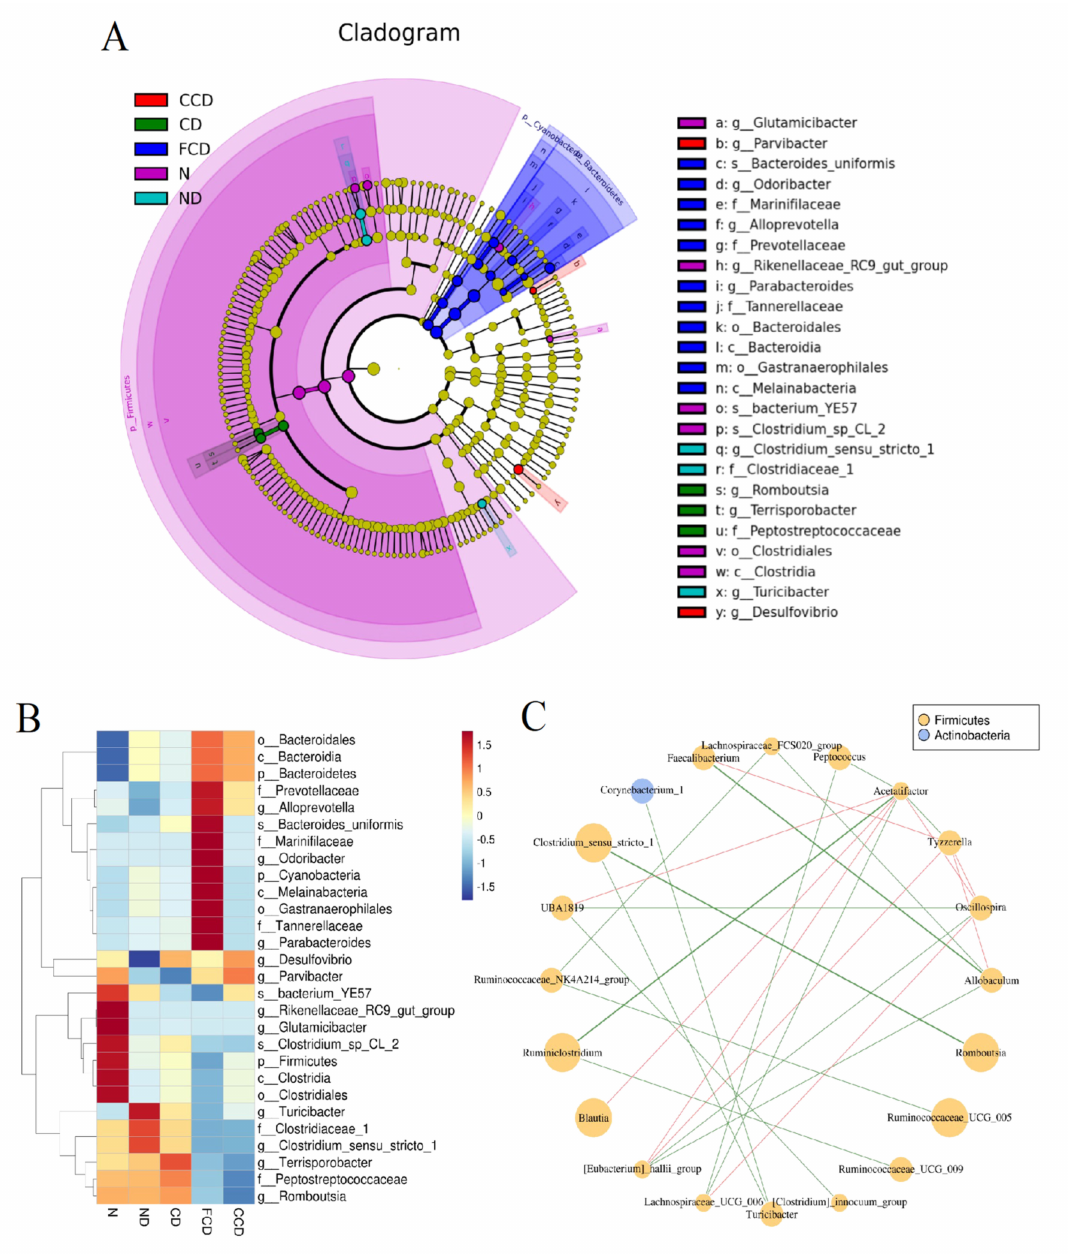
Figure 3. Linear discriminant analysis effect size analysis of microbiota compositions and network analysis of taxa. ( A ) Cladogram of microbiota compositions excluding the PCD group; ( B ) Heatmap of microbiota relative abundance; ( C ) Spearman’s correlation analysis of microbiota taxa, r cutoff = 0.7. Green lines indicate positive correlations. Red lines indicate negative correlations ( n =